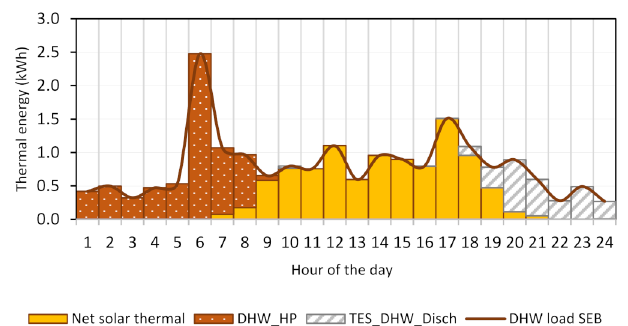
Figure 27. Thermal energy balance of the SEB for domestic hot water obtained with stochastic economic optimization for the representative summer